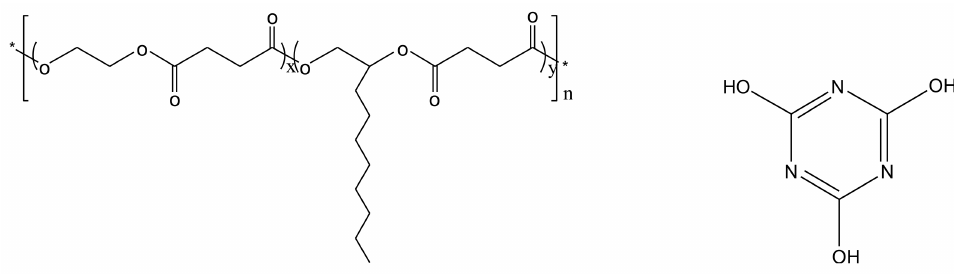
Figure 1. Chemical structures of b-PES ( left ) and CA ( right